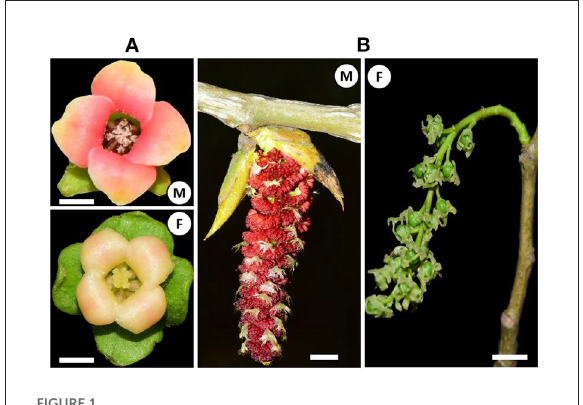
FIGURE1 Unisexual flowers of Diospyros lotus (Type I flower) (A) and Populus deltoides (Type II flower) (B) . M, male flower; F, female flower. Scale bar = 1